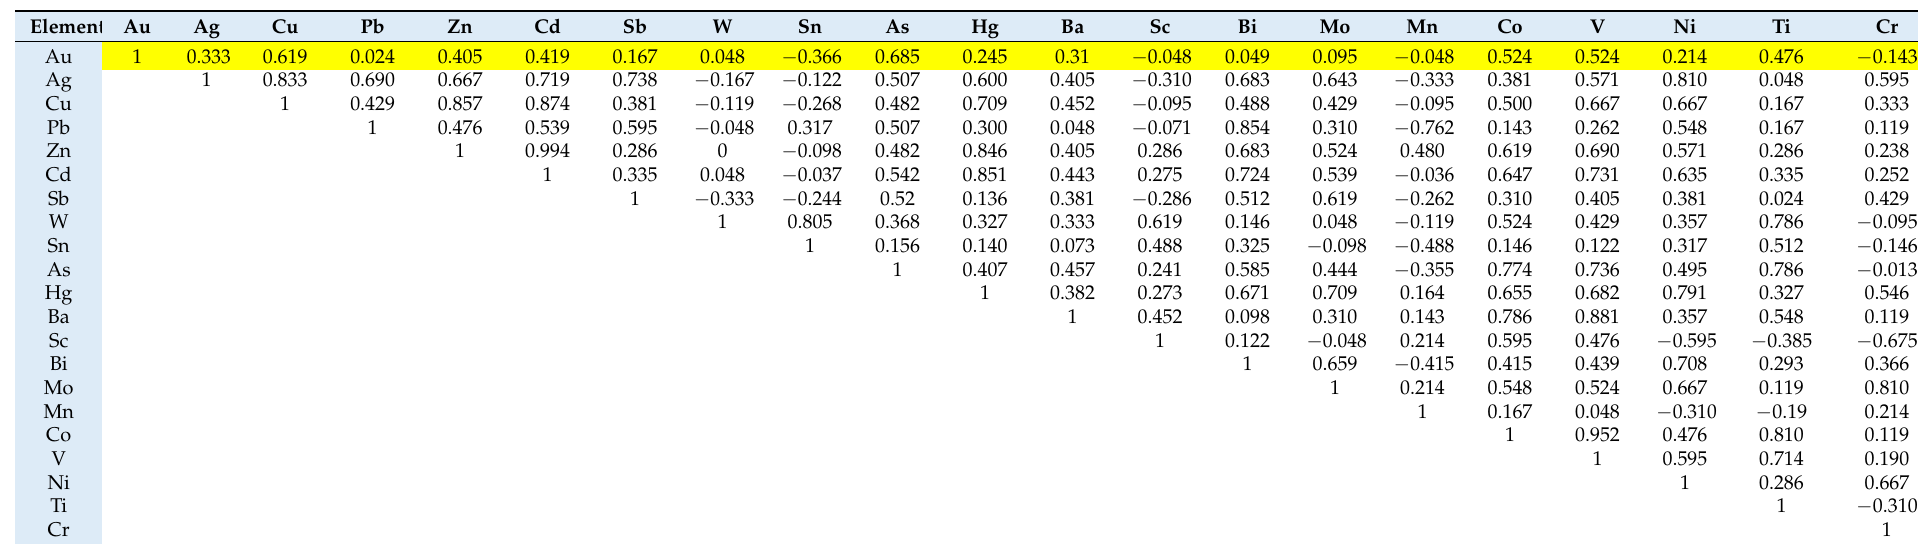
Table 1. Correlation coefficient matrix for trace